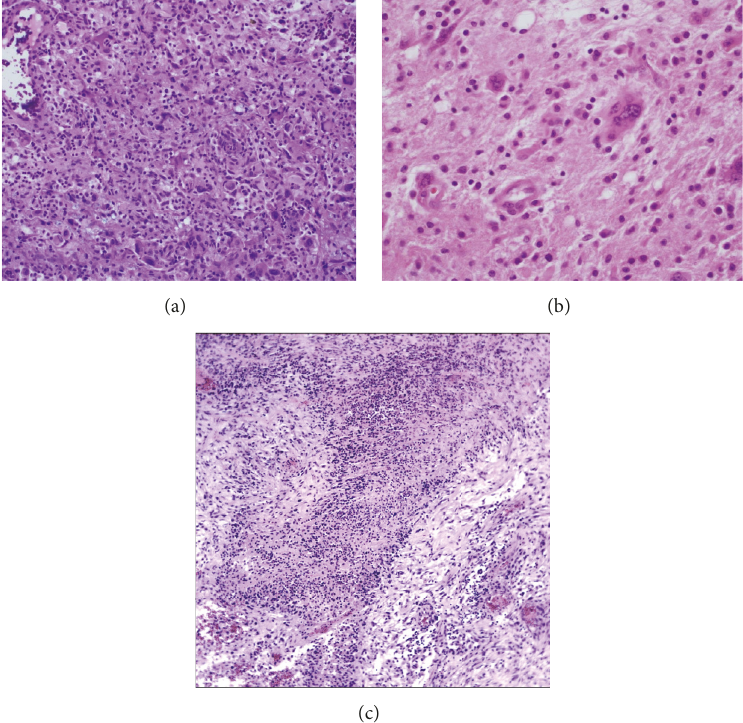
Figure 2: Brain tumor. (a) The tumor is composed of large and small cells (LFB/H&E, 100x). (b) The tumor contains many multinucleated giant cells (LFB/H&E, 400x). (c) The tumor displaying necrosis with palisade (H&E,